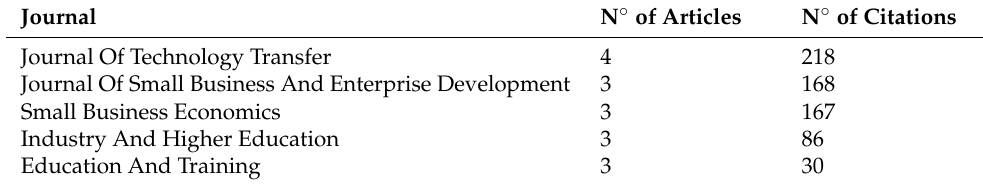
Table 3. N ◦ of analyzed articles and citations per journal.